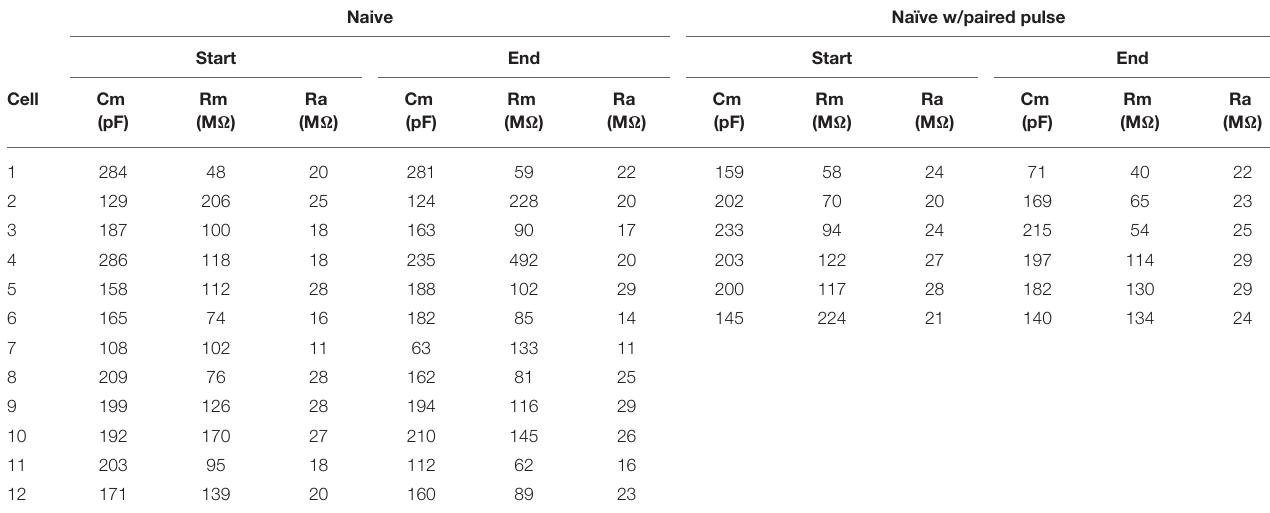
TABLE 5 | Membrane properties for experiment shown in Figure 6 .